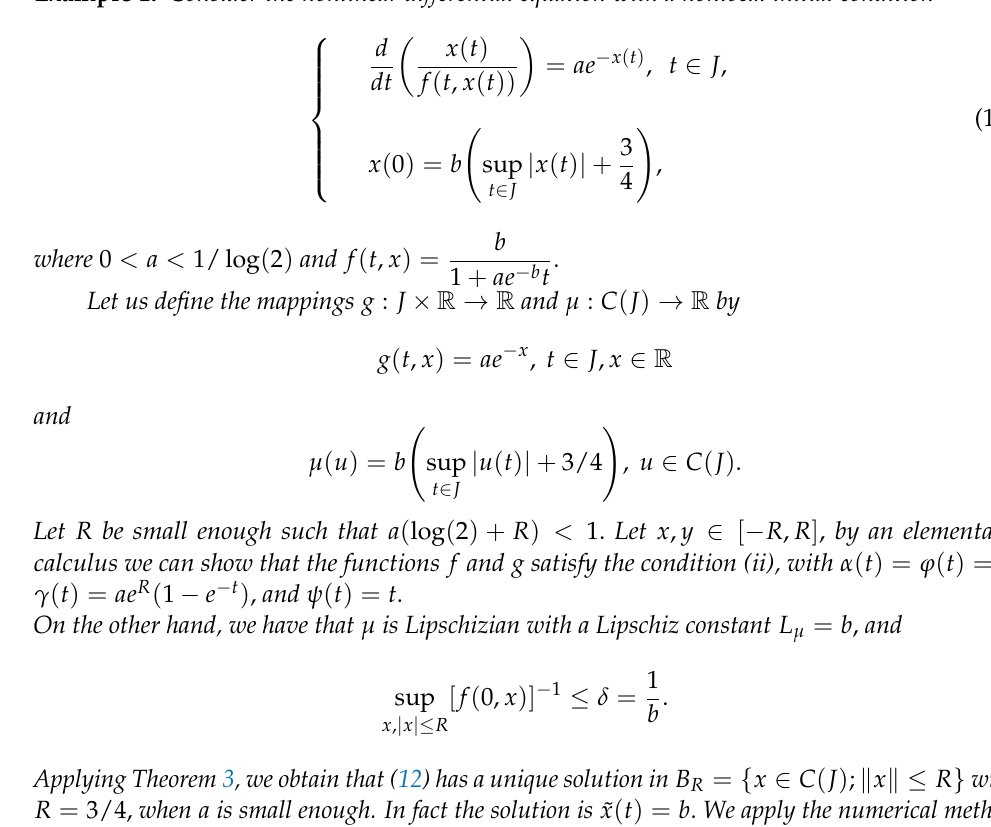
(cid:16) √ (cid:17) bt + 1 . 4